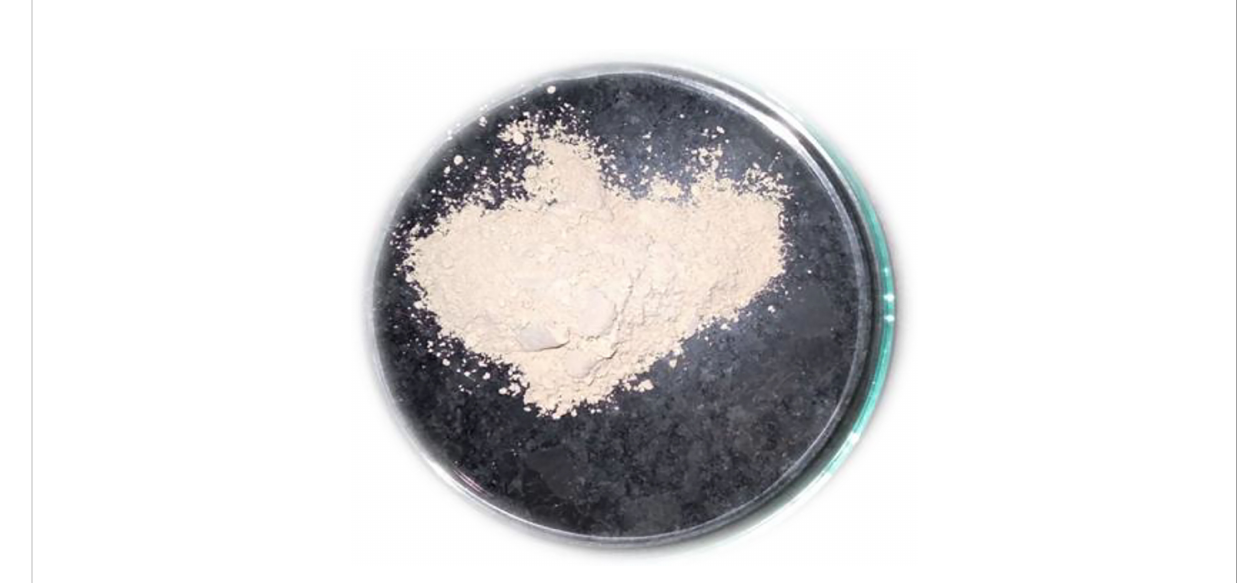
FIGURE 1 Extracted and spray-dried b -glucan powder from baker ’ s yeast Saccharomyces